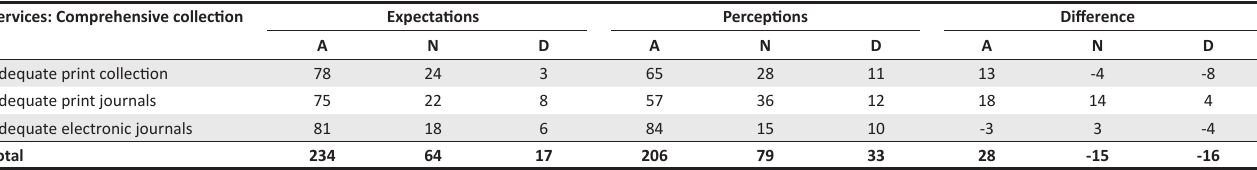
TABLE 1: Comprehensive